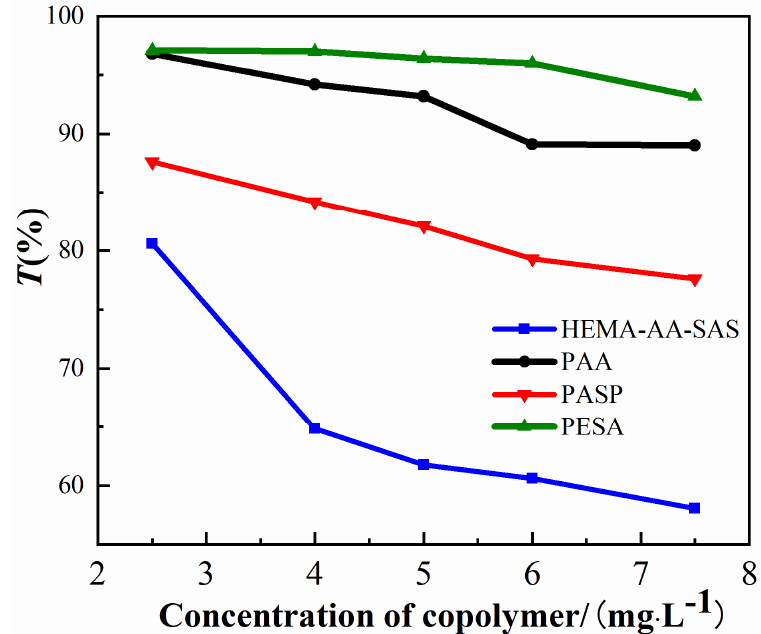
Figure 6. Influence of copolymer dosage on dispersibility silicon performance.